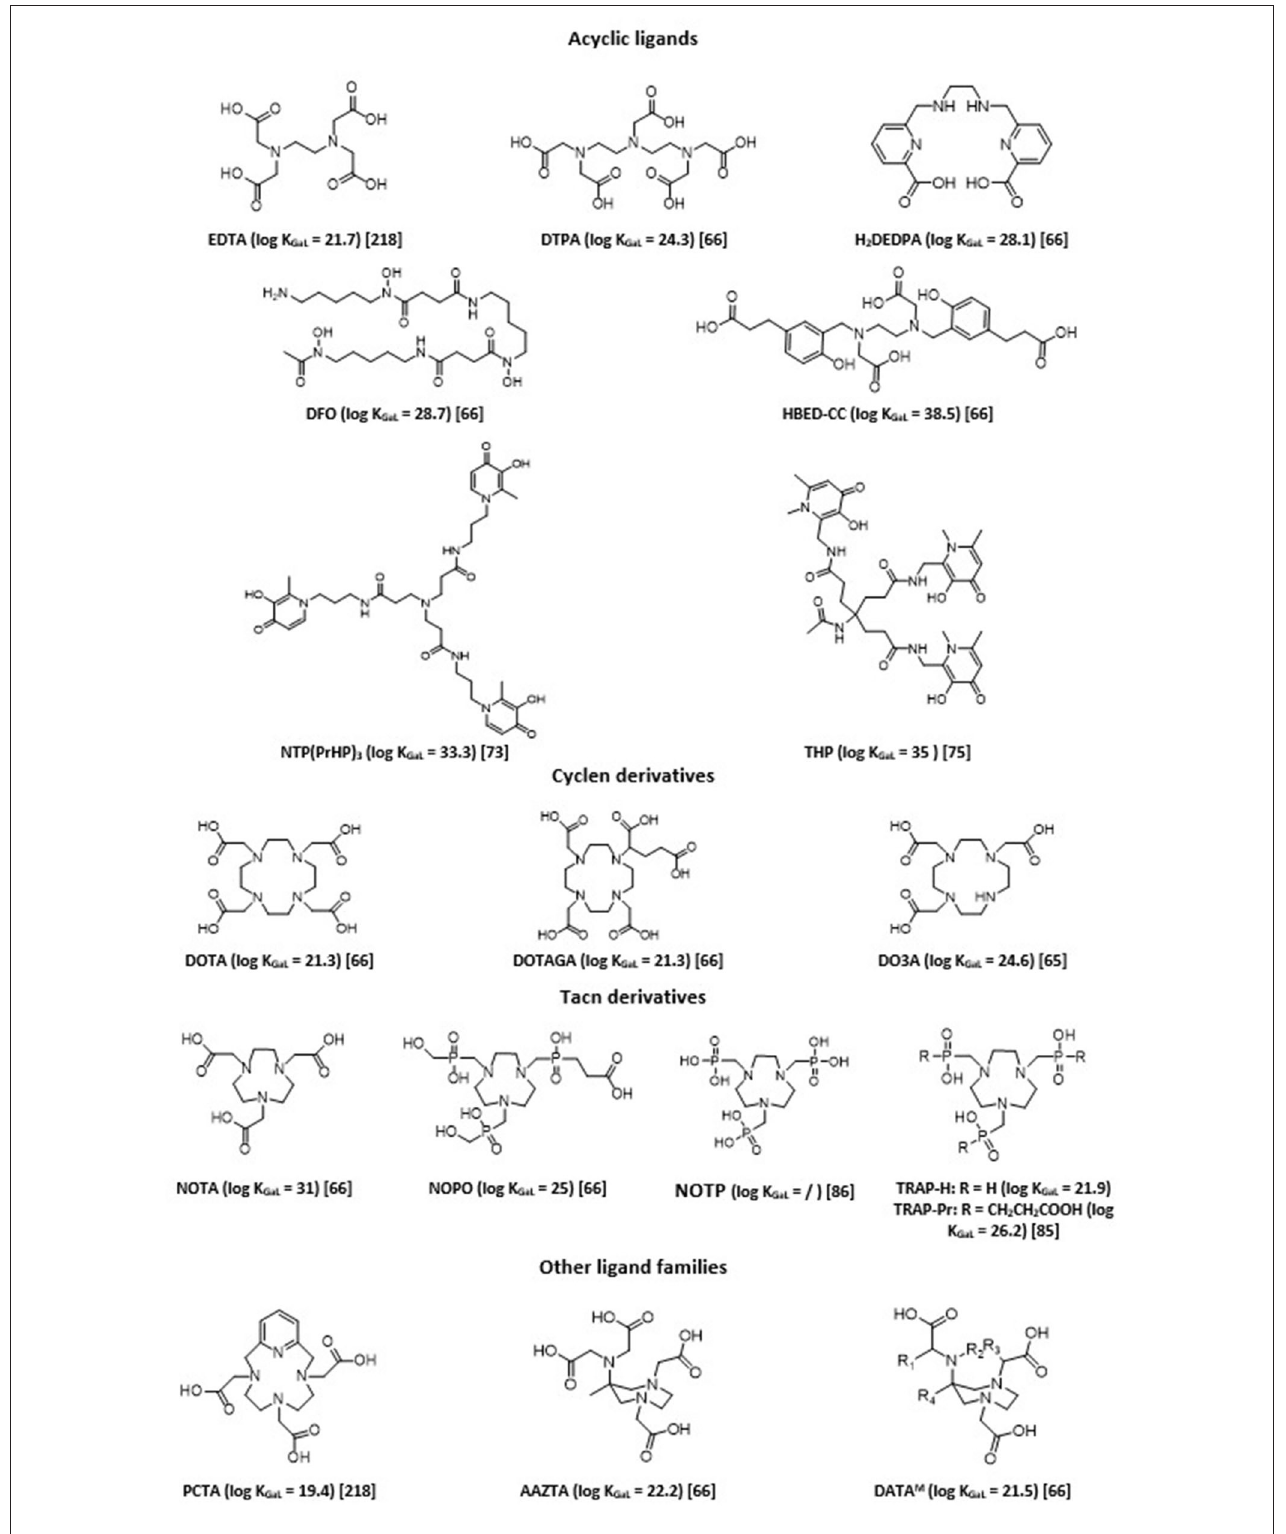
FIGURE 2 | Chelates commonly used with 68